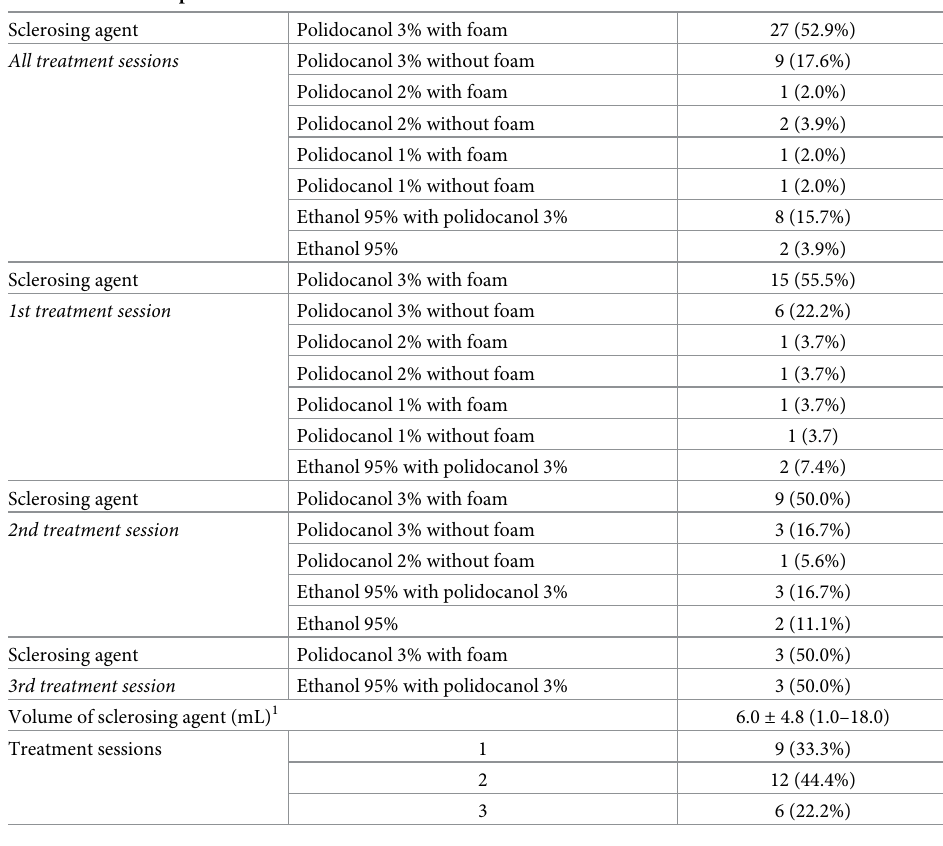
Table 1. Procedural parameters. Sclerosing agent Polidocanol 3% with